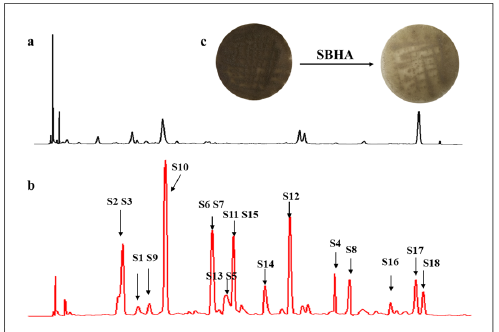
Figure 1. HPLC profile of extracts of A. aculeatus DL1011 cultivated with 150 μ M ( b ) SBHA and ( a ) control detected by UV absorption at 260 nm; ( c ) Mycelium color change of A. aculeatus DL1011 after 150 μ M SBHA treatment.